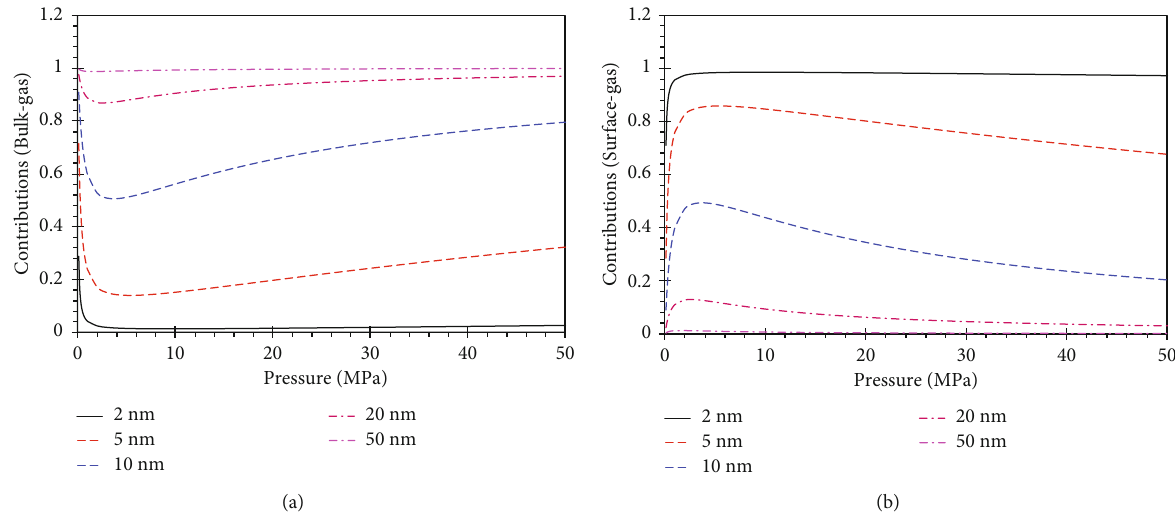
Figure 5: Contributions to the total gas conductance: (a) Bulk-like gas; (b) Adsorption gas